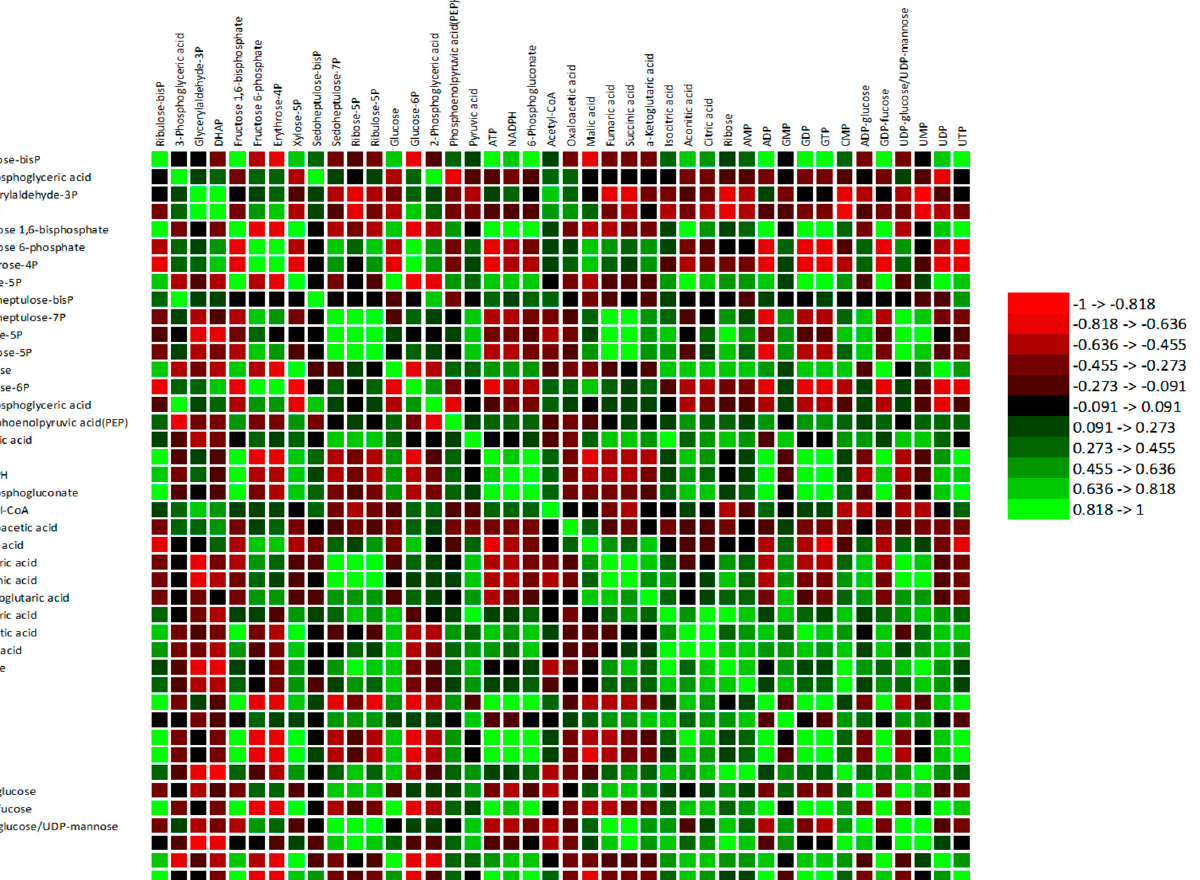
Figure 8. A heat map of the composite correlation matrix between individual metabolites of the central carbon metabolic routes in Mexican mint ( Plectranthus amboinicus ) plants in response to vary- ing watering regimes (n = 3). The red color represents a strong negative association, and the green color represents a strong positive association. Adenosine triphosphate (ATP), adenosine monophos- phate (AMP), guanine monophosphate (GMP), guanine diphosphate (GDP), adenosine diphos- phate (ADP), guanine triphosphate (GTP), uridine monophosphate (UMP), cytosine monophos- phate (CMP), uridine triphosphate (UTP), uridine diphosphate (UDP), ADP-glucose, GDP-fucose, and UDP-glucose/UDP-mannose.